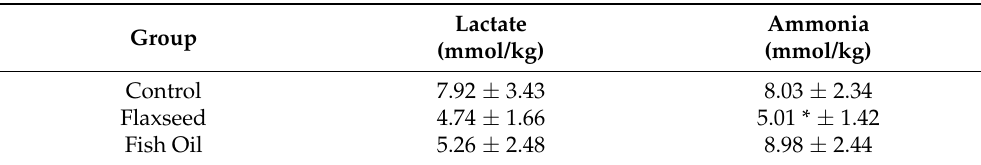
Table 2. Caecum lactic acid and ammonia quantification in the three experimental groups, Control ( n = 5), Flaxseed ( n = 5), and Fish oil ( n = 5). Results are expressed as mean ± standard deviation. * p < 0.05 vs. control group.